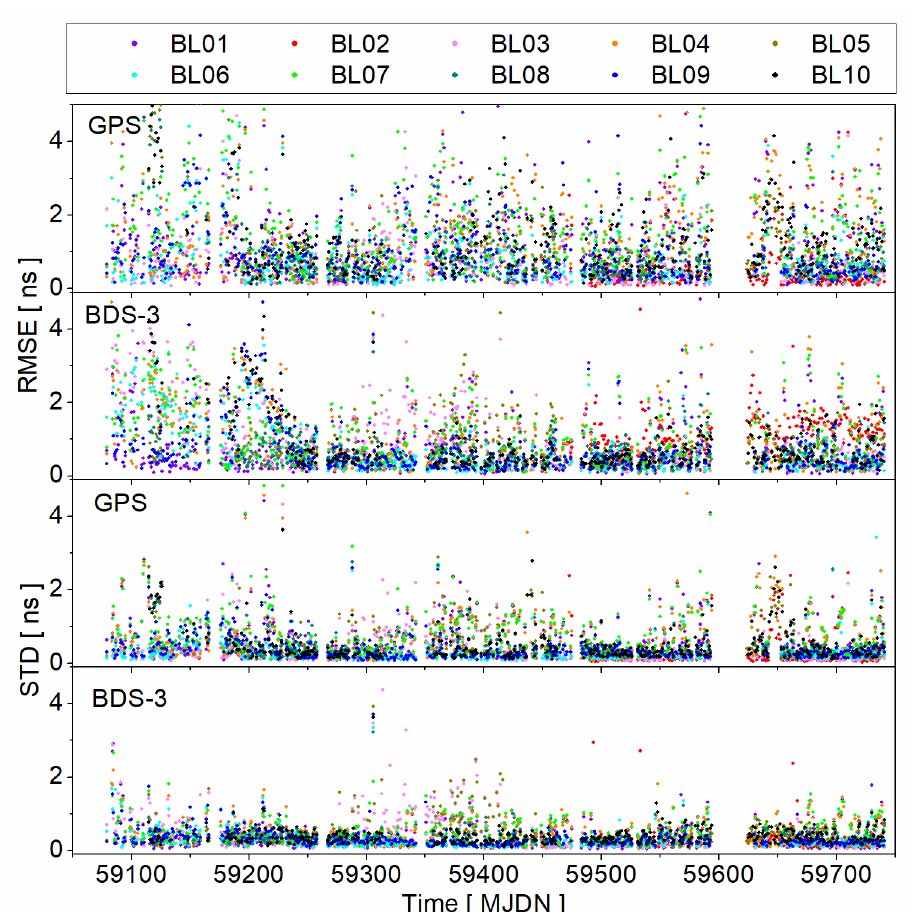
Figure 12. RMSE and STD series of time synchronization from 10 baselines; the 1st and 2nd panels represent RMSE of time synchronization for GPS and BDS-3, respectively; the 3rd and 4th panels represent STD of time synchronization for GPS and BDS-3, respectively.